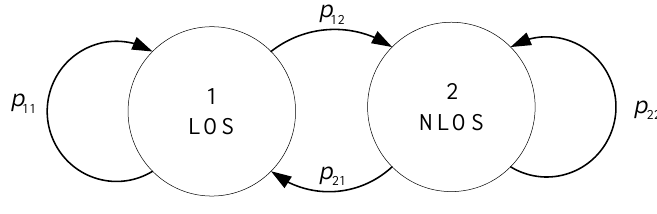
Figure 1. Markov switching model.